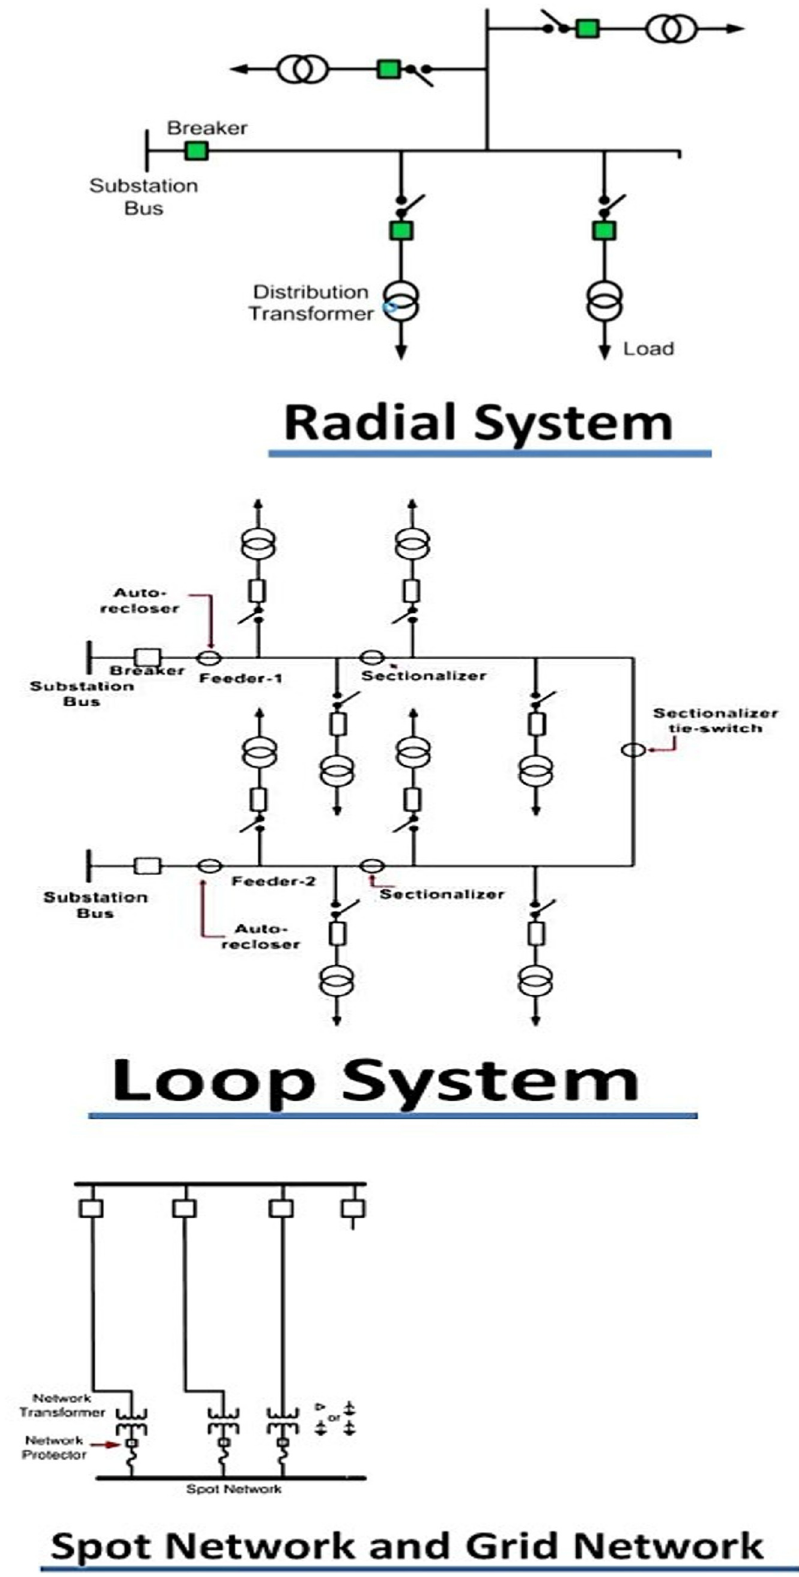
Figure 3. Electricity distribution schemes.